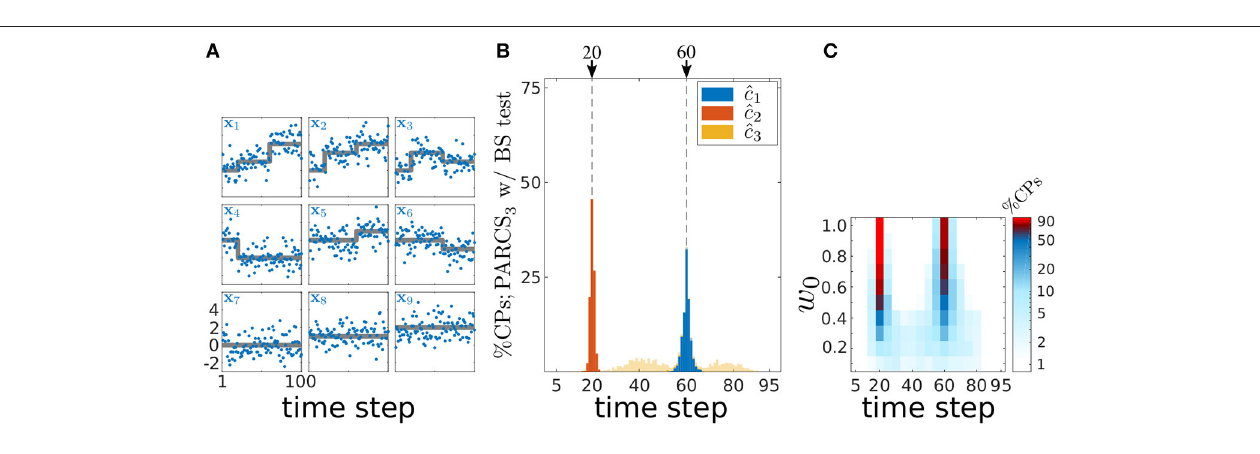
FIGURE 7 | Multiple CP detection in spatially independent, multivariate data; (A) deterministic component of the different covariates in the time series (gray) superimposed on an exemplary time series (blue); (B) stacked histograms of correct detection rates over 1,000 realizations; transparent bars show candidate CPs excluded by the permutation test; dashed gray, ground truth CPs; (C) stacked histograms of correct detection rates over 1,000 realizations given different signal-to-noise ratios (controlled by w 0 ), and binned with 5 time step windows; rates are logarithmically scaled as indicated by the color